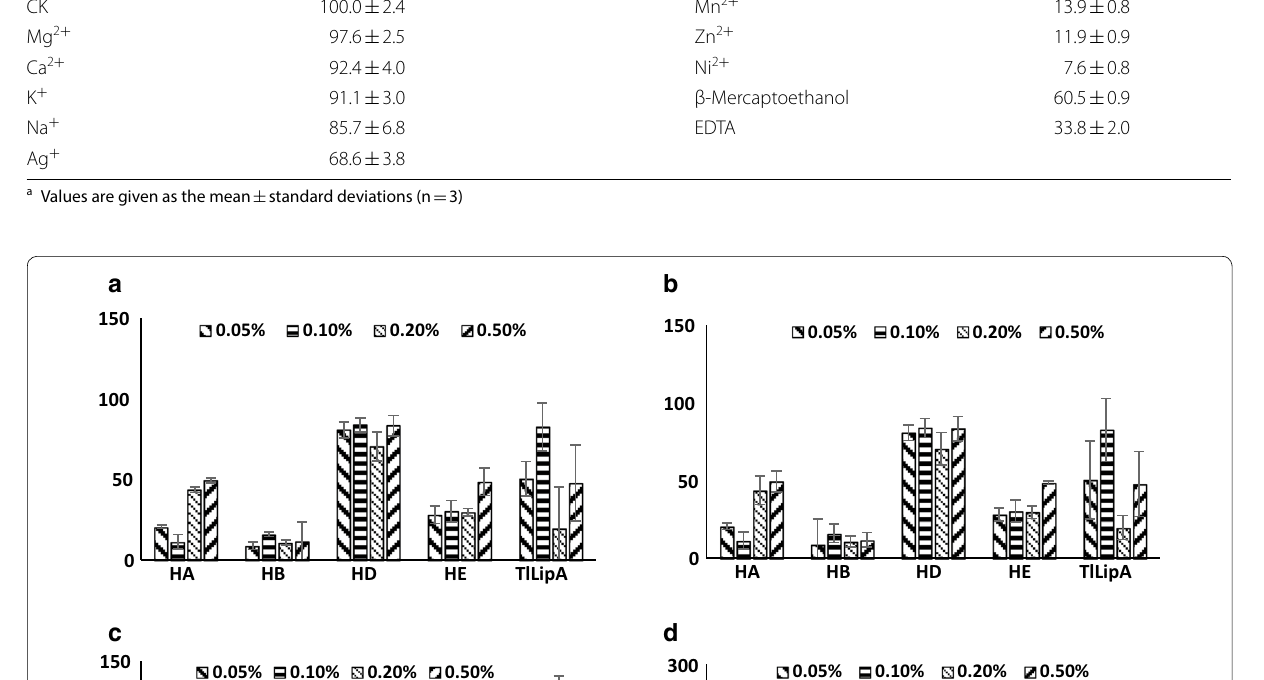
Table 2 Effects of metal ions and chemical reagents on the Tl LipA activity